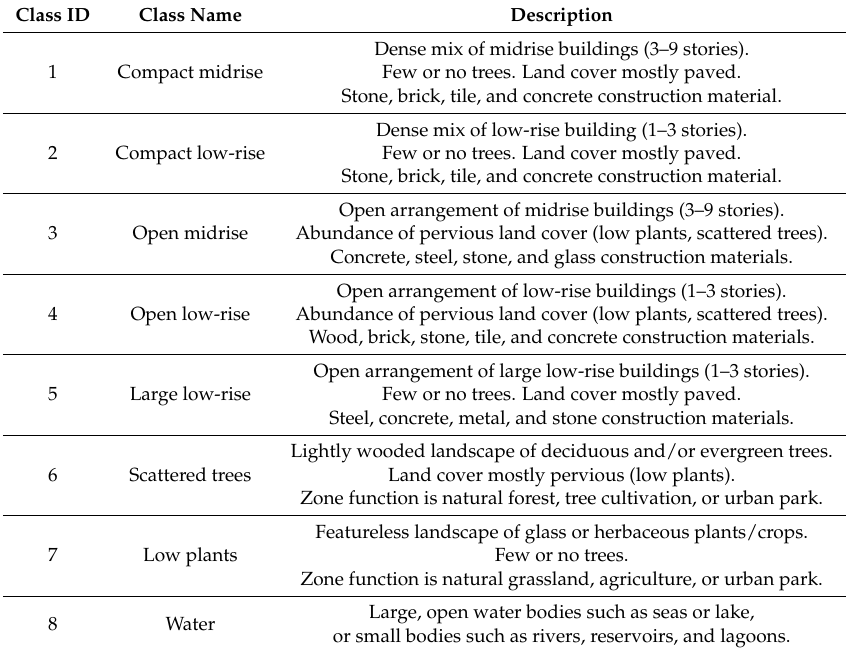
Table 3. Local Climate Zone (LCZ) classes retained for the city of Milan: ID, Name, and Description